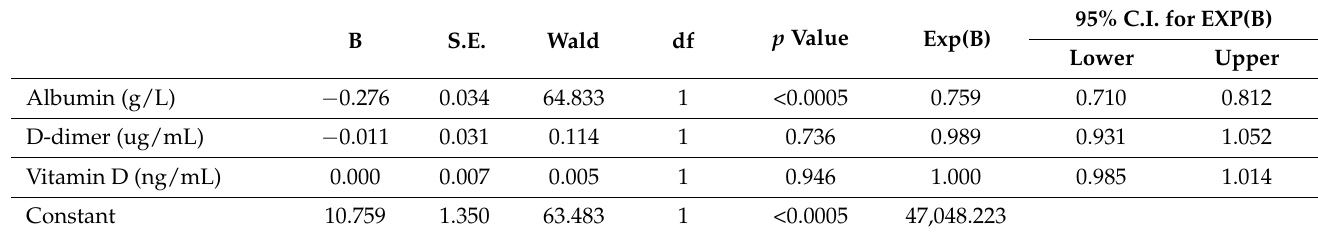
Table 4. Prediction of the probability of developing a severe clinical picture in patients with COVID- 19. The serum values of the biochemical parameters were obtained from blood samples immediately after admission to the hospital for treatment (n = 288). Statistical significance was examined using the binary logistic regression. Values of p < 0.05 were considered statistically significant.